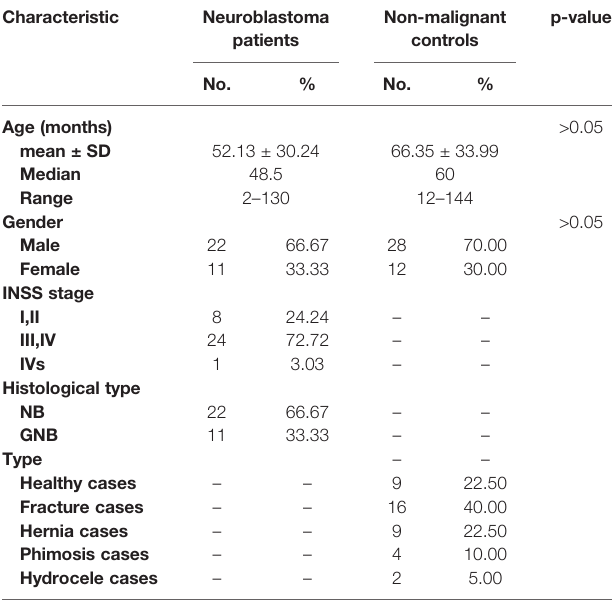
TABLE 1 | Characteristics of neuroblastoma patients and non-malignant controls.